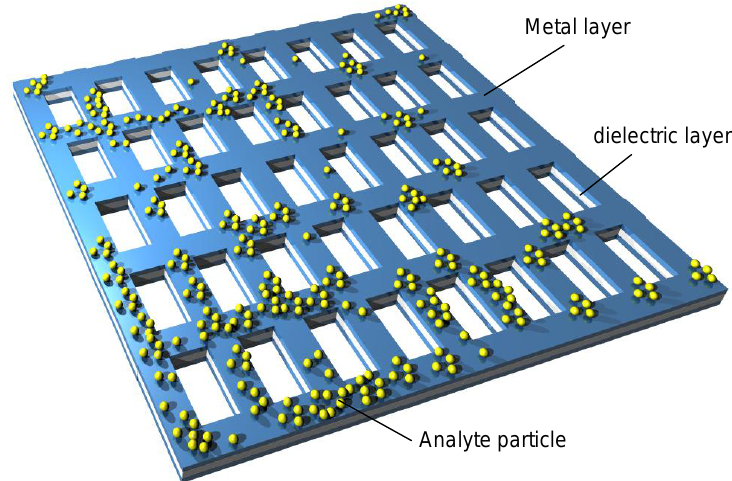
Figure 8. A segment of a double fishnet structure based on a freestanding nanomembrane; rectangular apertures in a square